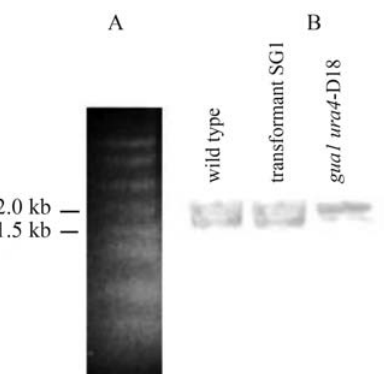
Figure 3 - Northern blot analysis of inosine monophosphate dehydroge- nase (IMPDH) transcripts in the Schizosaccharomyces pombe wild-type, mutant and SG1 transformant. Total RNA (~10 (cid:4) g) was separated using denaturingformaldehyde/agarosegelelectrophoresis.RNAmarkerssepa- rated on agarose gel (a); Northern blot hybridization of IMPDH mRNA with a DIG-11-dUTP labeled DNA fragment carrying the gua1 gene as a probe.